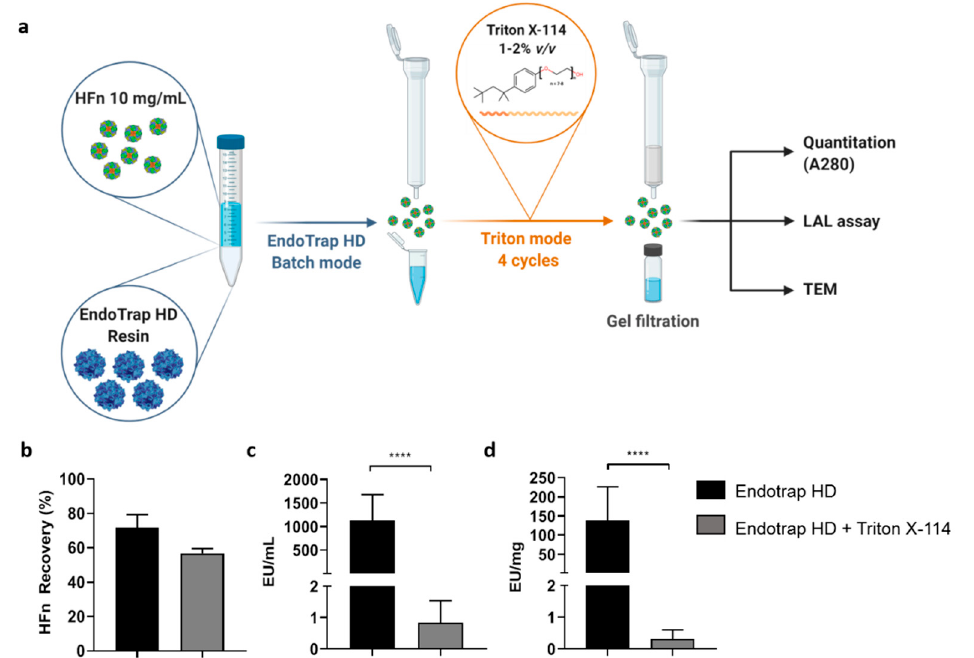
Figure 5. Combined Endotrap HD and Triton X-114 purification. Endotrap HD resin was incubated for 2 h with HFn (10 mg/mL; 1:1 ( v/v ) ratio) and eluted using an empty column, as described for batch mode in Figure 2a. The resulting HFn has been supplemented with 1% Triton X-114 and treated for 4 cycles of purification ( a ). HFn recovery was calculated by absorbance reading ( b ), while ETX levels have been obtained by LAL test ( c , d ). Results are reported as average ± S. D. of 6 independent experiments. Statistical significance: **** p < 0.0001